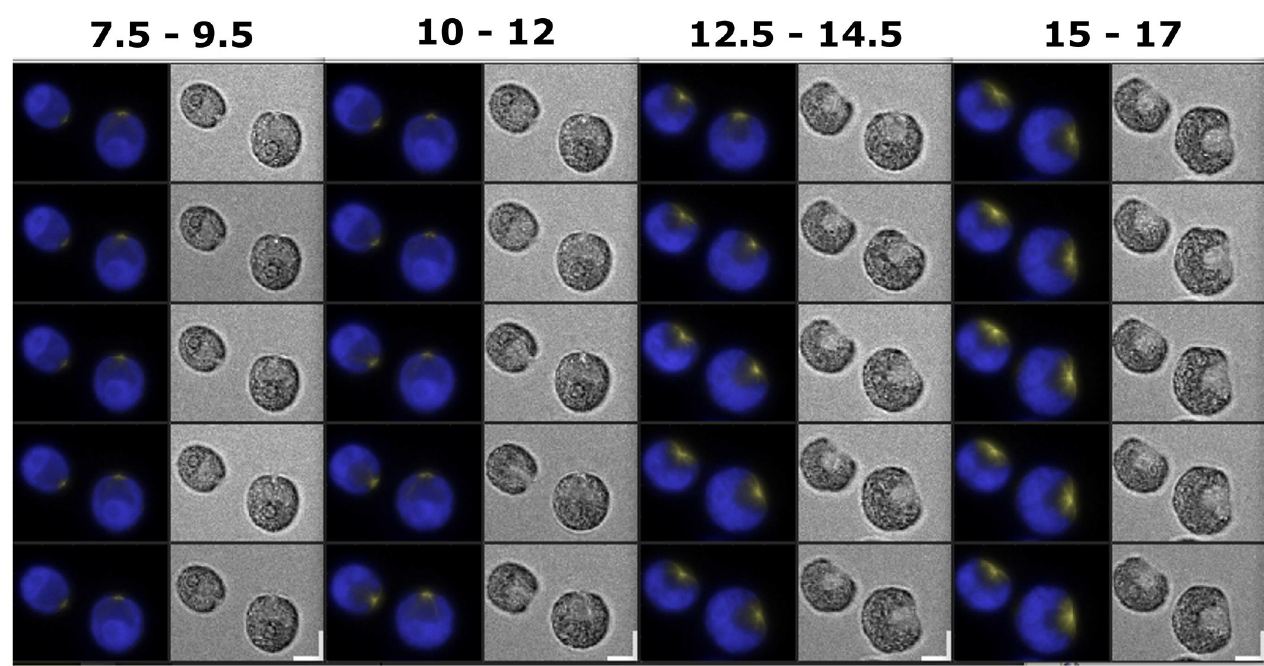
Fig 8. Live cell time-lapse of cycb1-5 ; EB1 : NG-TG cells. Live cell time-lapse acquired with microscopy method 1 (see Methods section). Each cell has a brightfield image (right), and a composite of EB1-NG signal in yellow and chloroplast autofluorescence signal in blue (left). Time indicated on top of each strip is hours after beginning of time-lapse. The indicated time corresponds to the top cell in each strip. Each subsequent cell going down is from an image captured every 30 minutes.